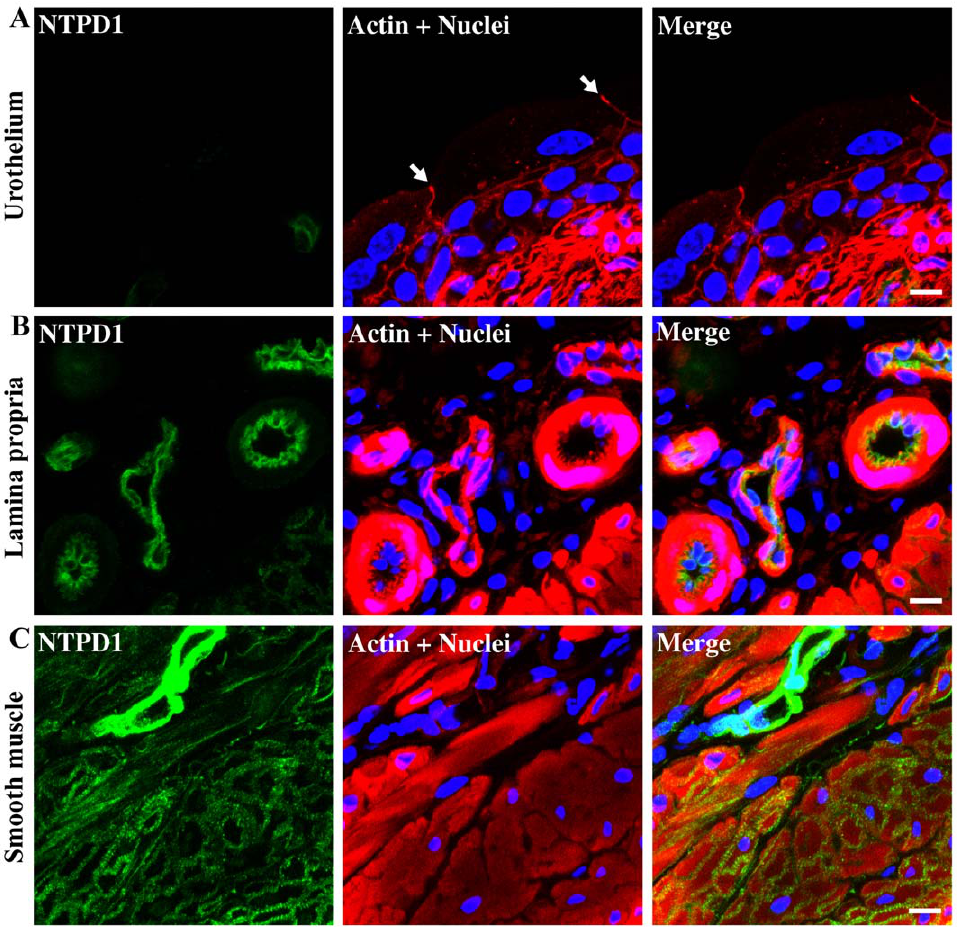
Figure 3. Immunolocalization of NTPD1 in different regions of the bladder. Cryosections of mouse bladders were labeled with antibodies to NTPD1 (green), rhodamine phalloidin to label the actin cytoskeleton (red) and Topro-3 to label nuclei (blue). Color merged panels are shown on the right. A) NTPD1 staining at the level of the urothelium; white arrows indicate tight junctions between superficial umbrella cells, B) NTPD1 staining at the level of the lamina propria, C) NTPD1 staining at the level of the detrusor smooth muscle. White scale bars =10 m m.